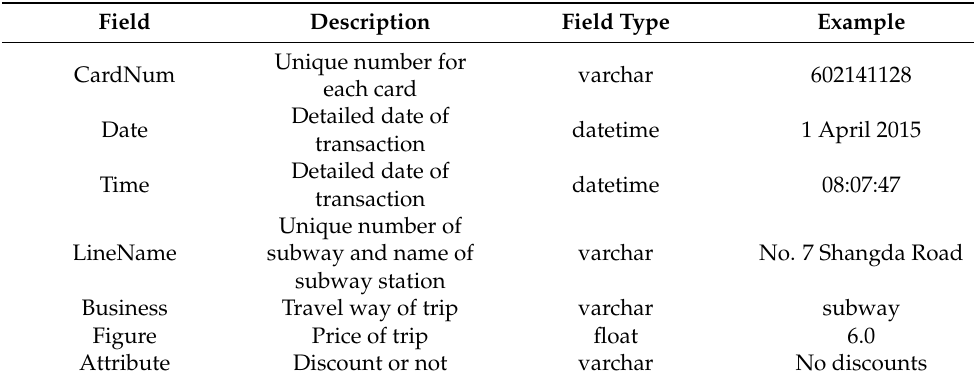
Table 1. Data structure of the SCD and Example